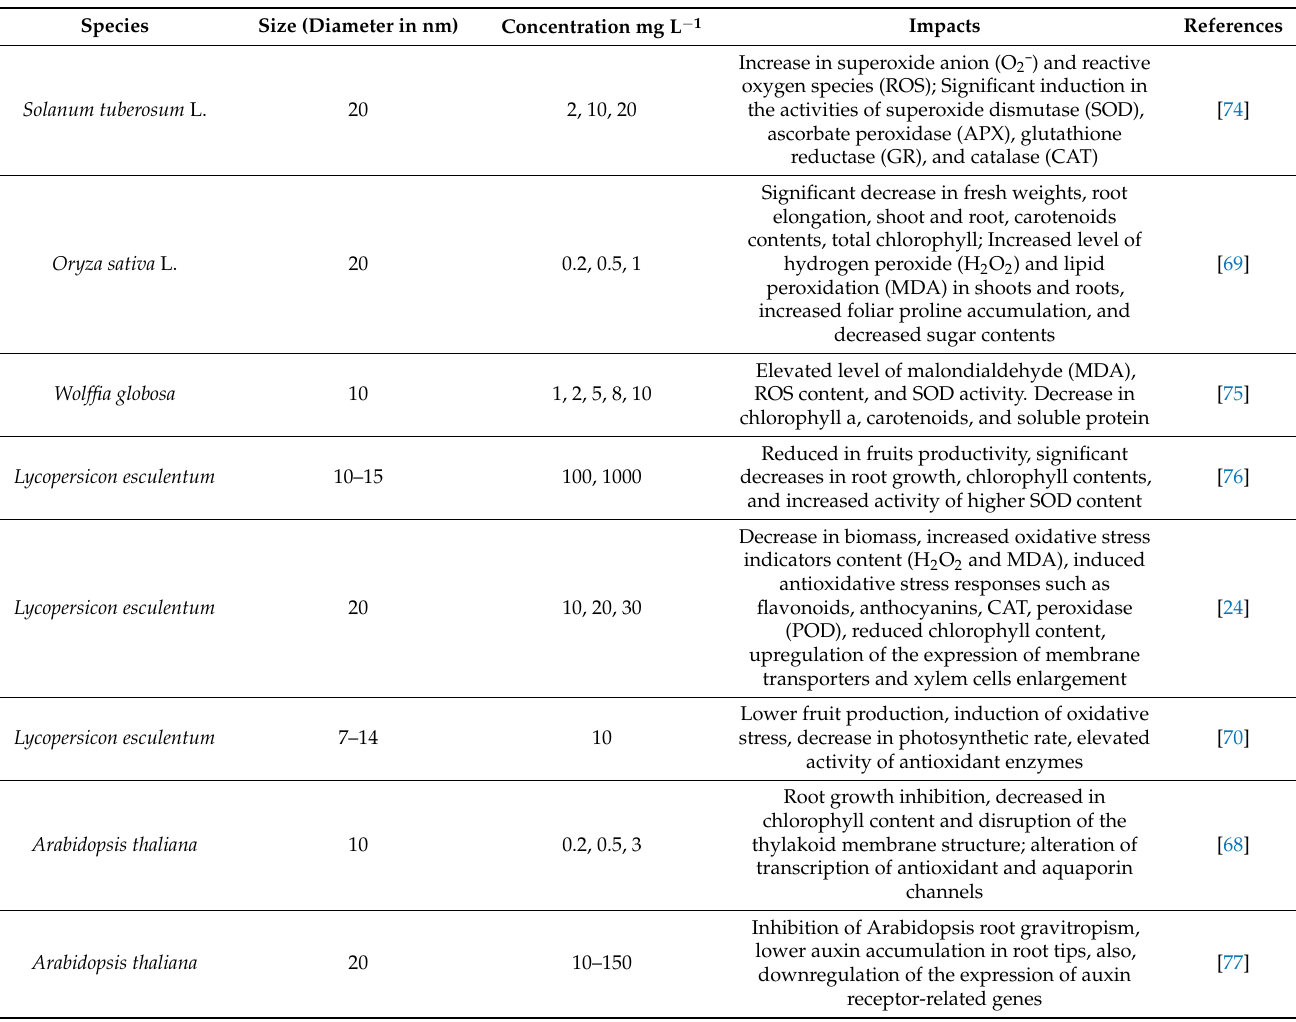
Table 1. The effects of AgNPs on